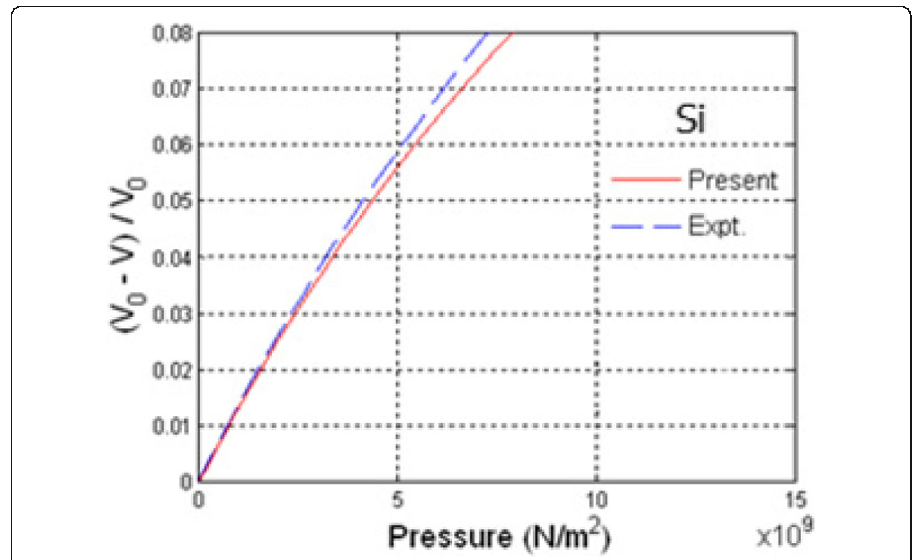
parameters of J. C. Slater (solid line and symbol □ ) [10], and simultaneously show